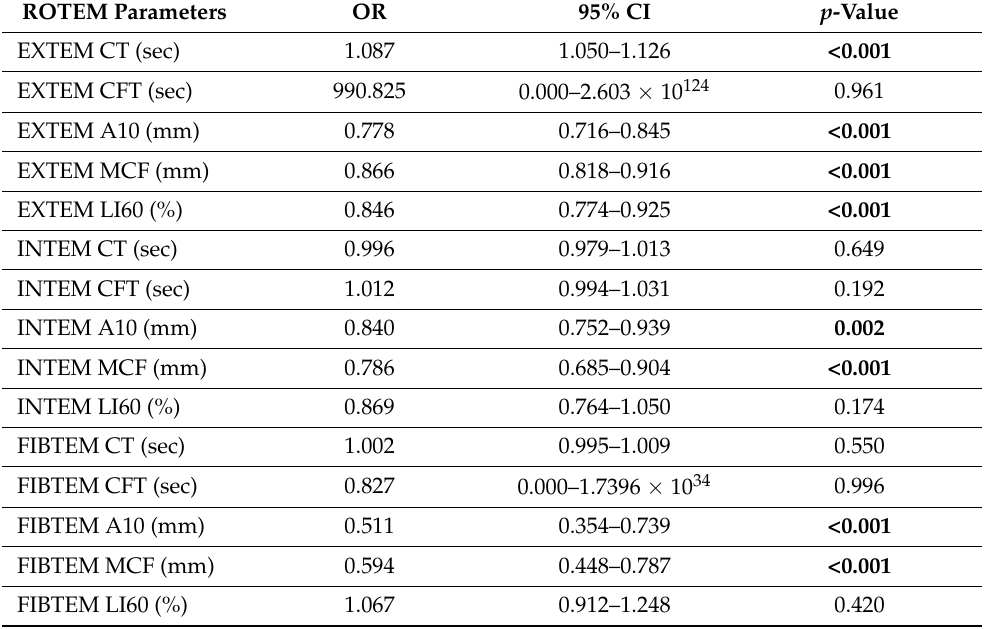
Table 4. Results of the multivariable logistic regression analysis for RDS as the dependent variable, with ROTEM parameters, age (preterm vs. postterm), sex, BW, and perinatal hypoxia/fetal distress as independent variables.